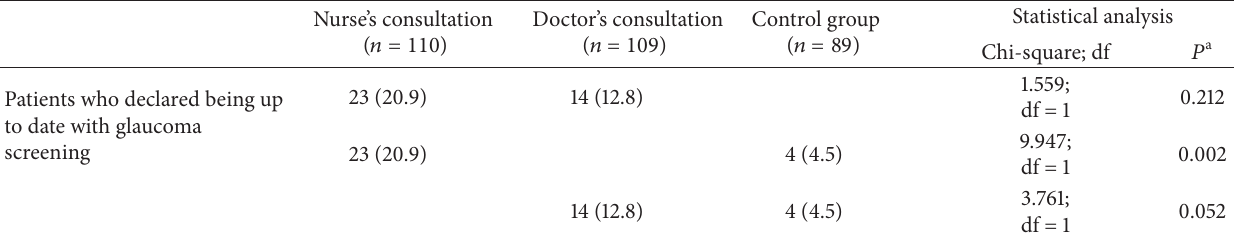
Table 2: The effectiveness of interventions as compared to